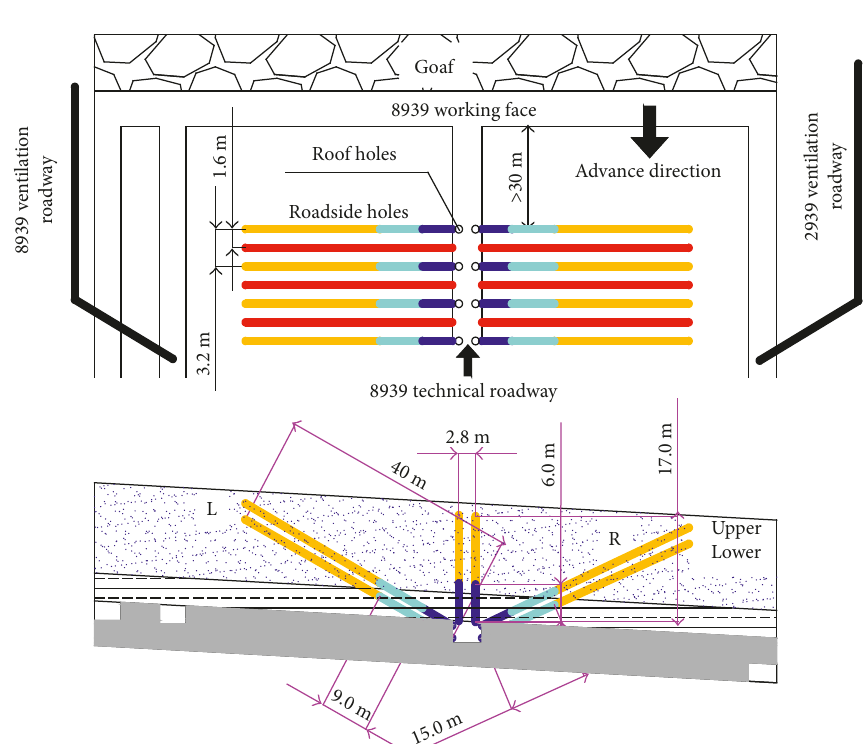
Figure 20: Presplitting blasting profile of each blast-hole group.